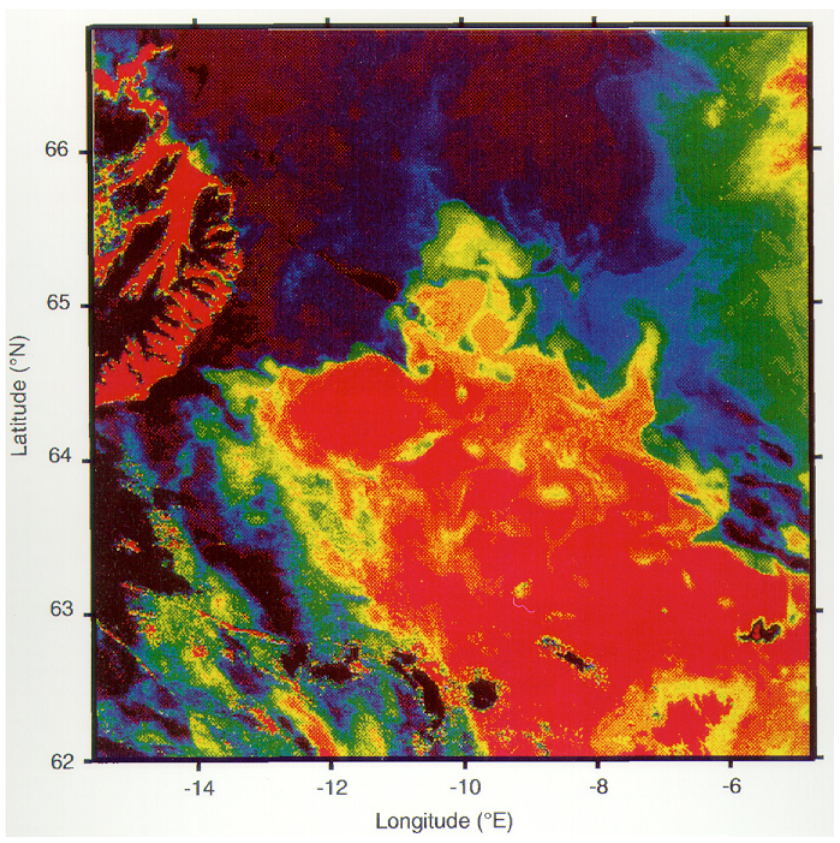
Fig. 2. Satellite AVHRR of the Iceland- Faeroes Frontal zone, indicating the front, the warm intrusion and a cold jet occurring at ! 11 ° E, 64 ° 30 (cid:64) N. Taken on 14 May 1988. Here warm tempera tures are red , cold temperatures blue . The bottom left corner of the image is obscured by